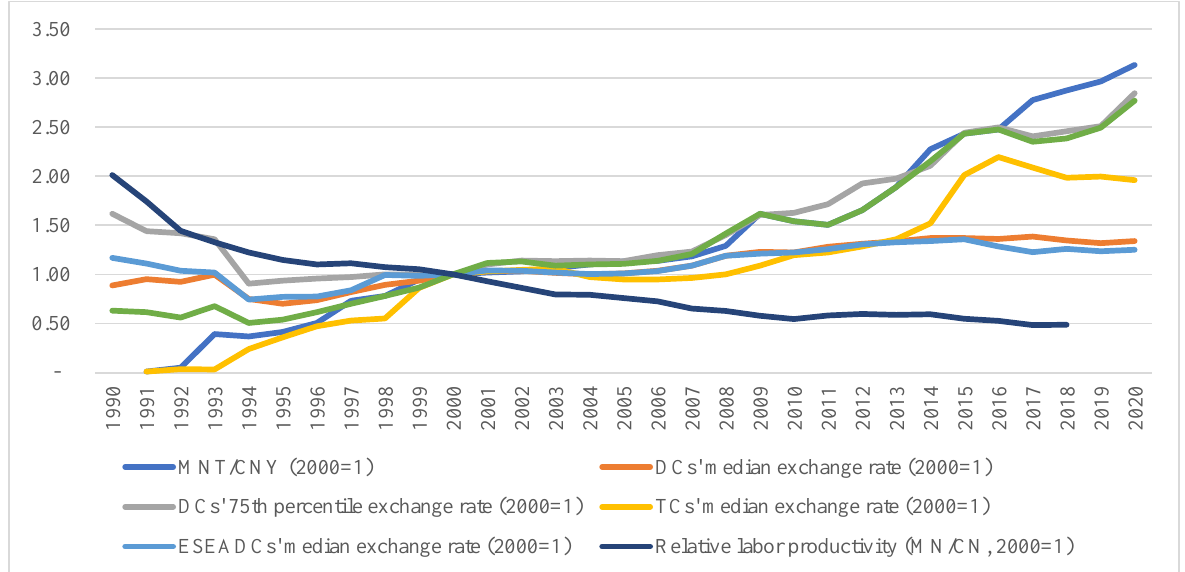
Figure 1. Exchange rate evolution of country groups comparable to Mongolia and relative labor productivity. Source: author’s estimation based on publicly available data from IFS, IMF and APO productivity database 2020. Note: Relative labor productivity is the ratio of labor productivity of Mongolia to that of China. The country groups are based on United Nation’s country classification in 2020. We exclude Sudan, Suriname, Turkey and Zimbabwe due to the large depreciations in their currencies. Exchange rates are per Chinese Yuan in terms of specific country’s currency. DCs—Developing countries. TCs—Transition countries. ESEADCs—East and Southeast Asian developing countries. All series are normalized to 1 at